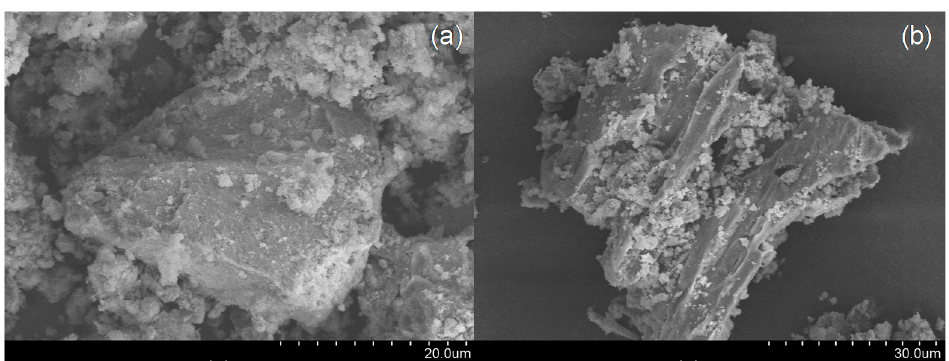
Figure 13. XRD patterns before and after caustic digestion using 50 wt% NaOH solution.